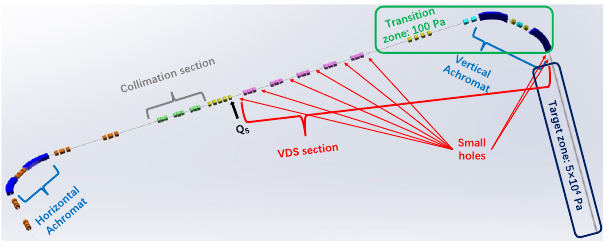
FIG. 2. CiADS A2T layout including VDS.